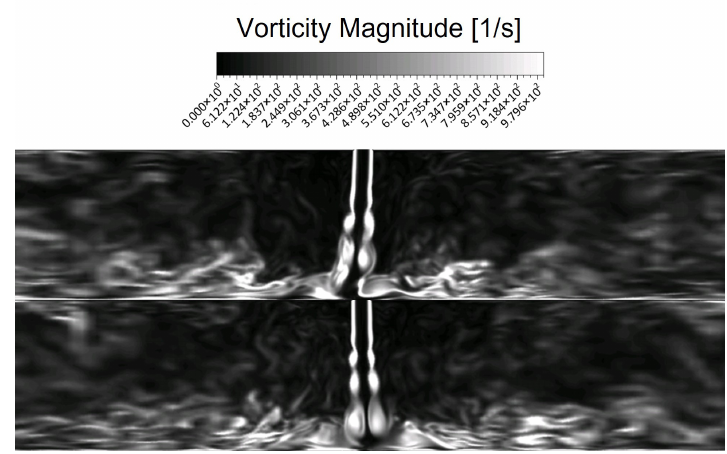
Figure 14. Instantaneous vorticity magnitude at two extremes of a period.